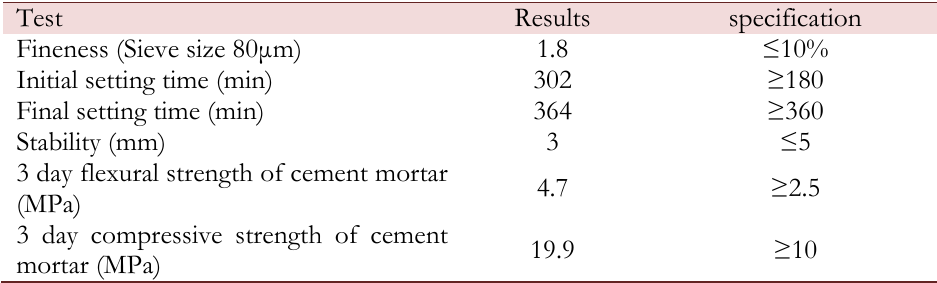
Table 1: The characterization of Xing’an Hailuo ordinary Portland cement PC32.5.